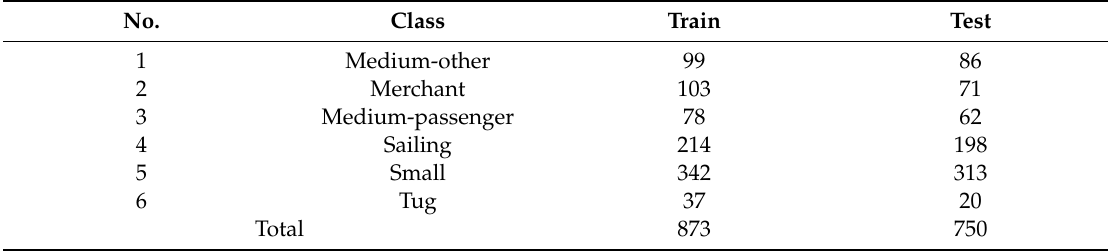
Table 6. Number of training and test samples using the VAIS